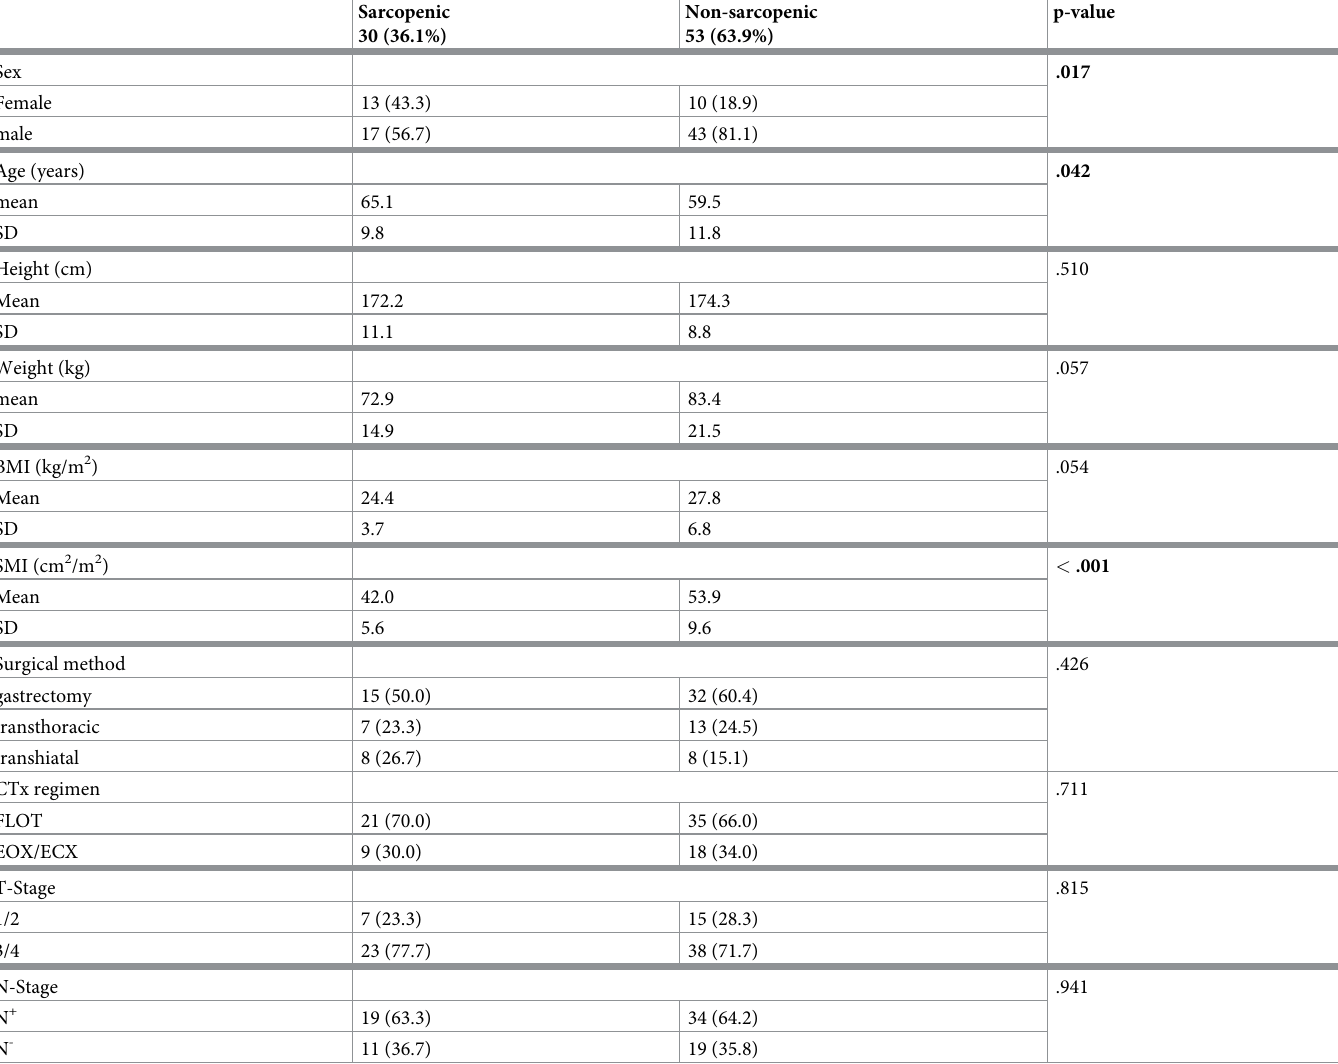
Table 1. Demographics; sarcopenic vs. non-sarcopenic patients.